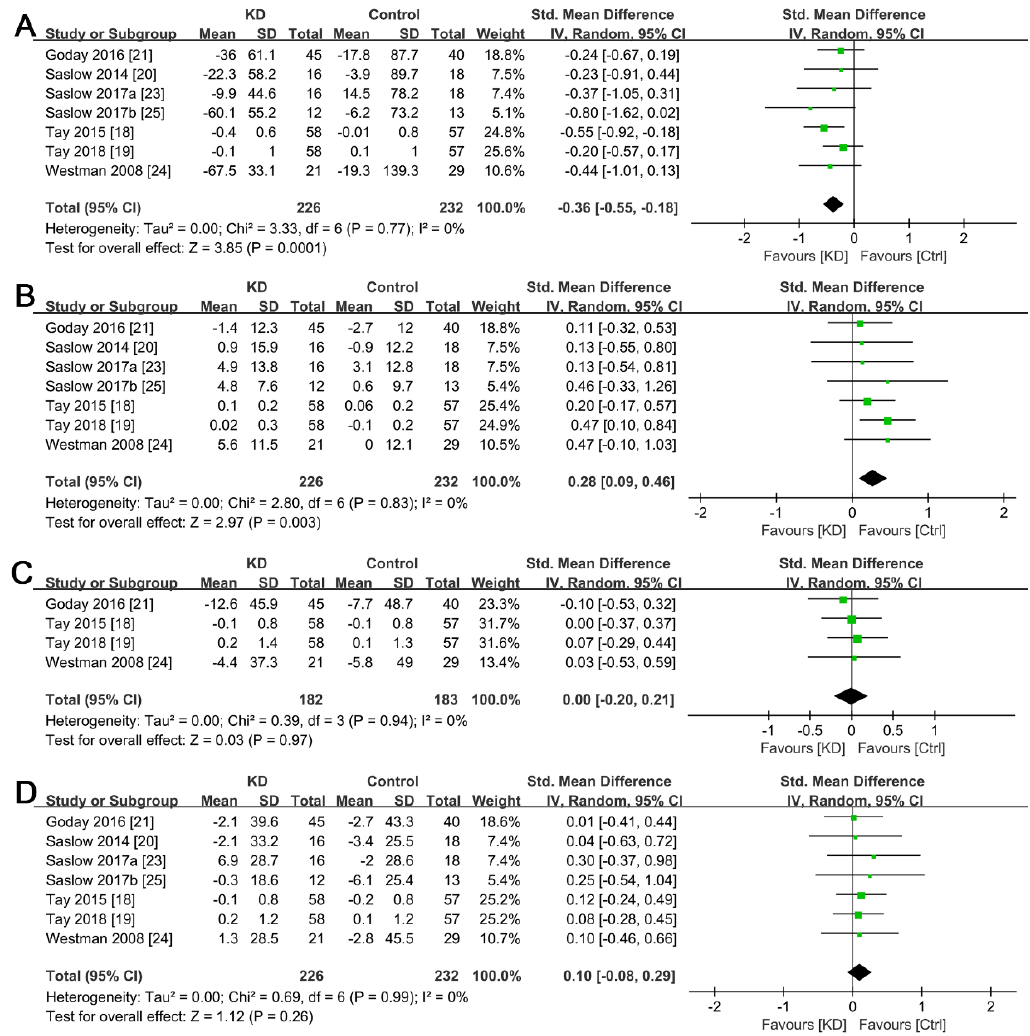
Figure 5. Forest plots for the effects of post-intervention versus baseline on lipid profiles in overweight T2DM patients. ( A ) Changes in fasting triglycerides; ( B ) Changes in HDL; ( C ) Changes in total cholesterol; ( D ) Changes in LDL. The green squares represent individual effect sizes, and the black diamonds represent pooling effect sizes.